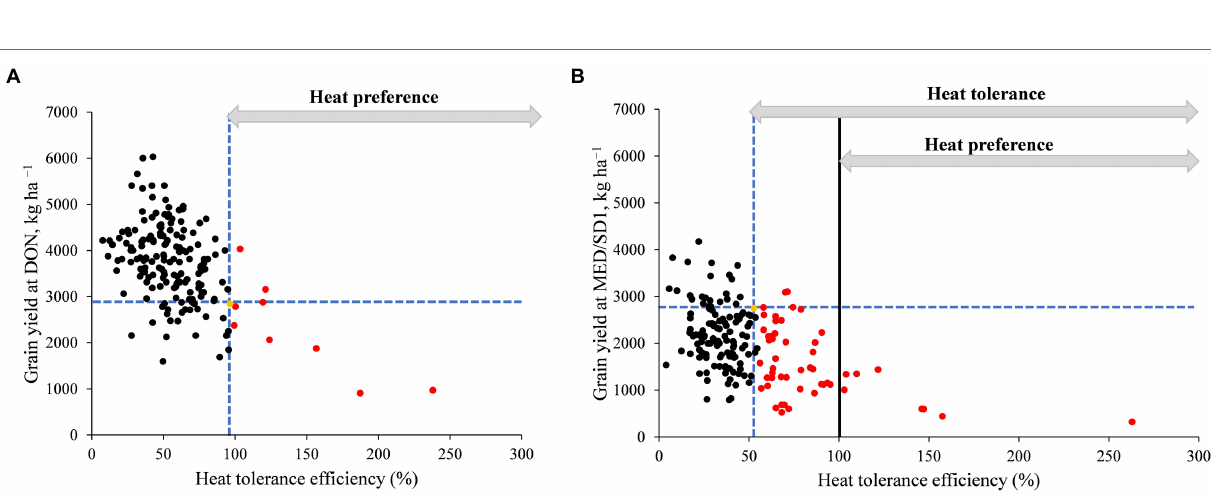
thresholds. The 32 MTAs identified for HI were scattered on